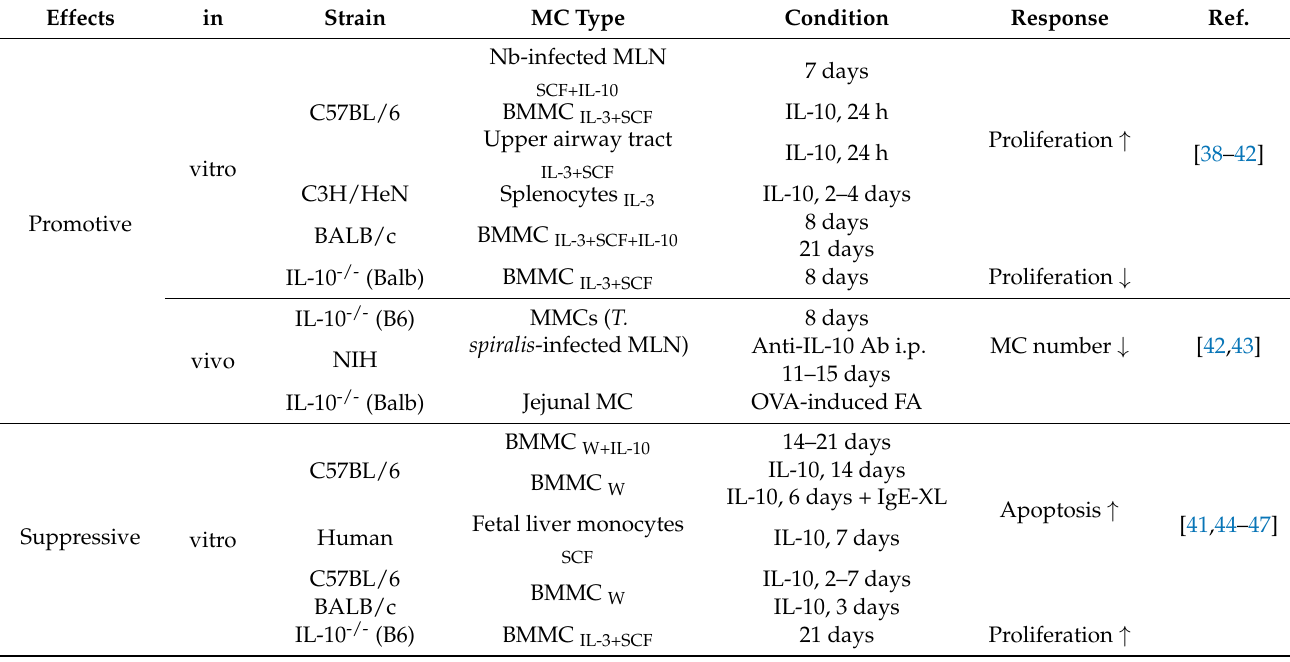
Table 1. Effects of IL-10 on proliferation and survival of